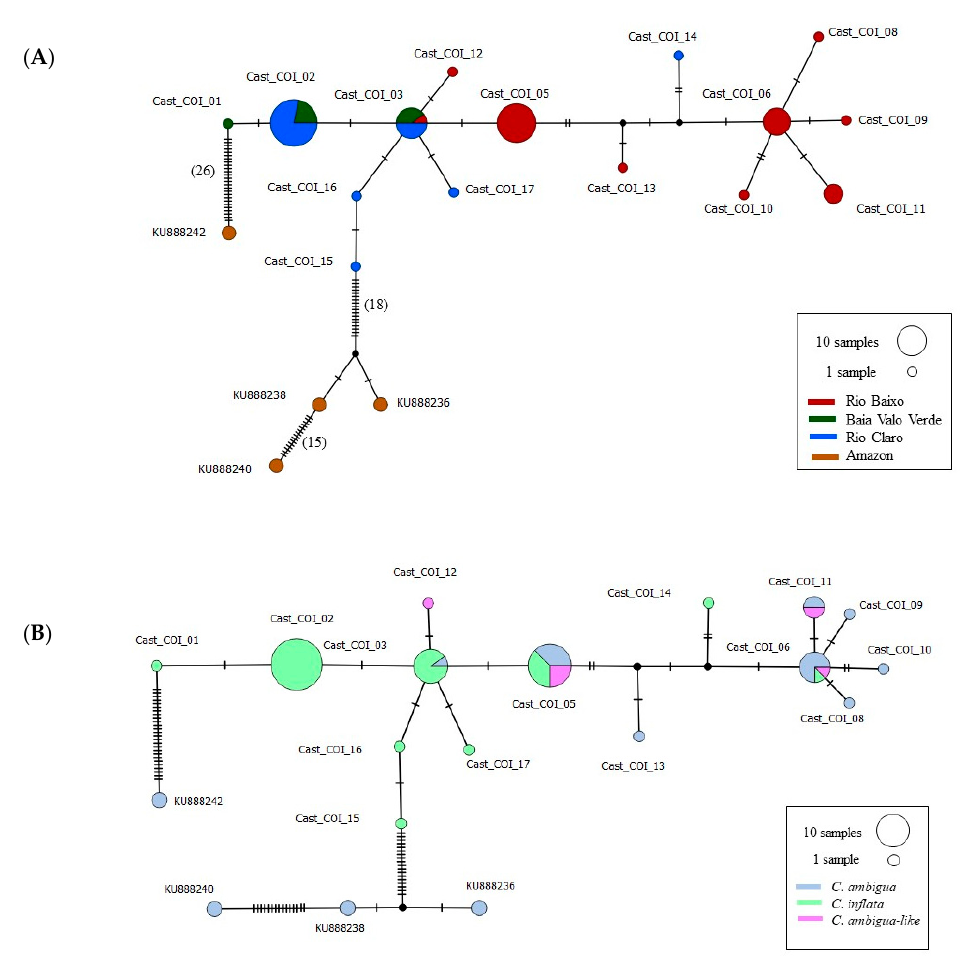
Figure 5. Haplotype networks for mitochondrial COI for C. ambigua and C. inflata across the Paraguay and Amazon River basins, considered: ( A ). on a geographic basis, and ( B ). on a taxonomic basis. The relative sizes of the circles reflect the frequencies of the respective haplotypes. Hash marks indicate the number of inferred mutations among haplotypes observed. Black dots represent inferred intermediate haplotypes that were not observed in our data set. Haplotype designations include Cast for Castalia , COI for cytochrome oxidase, and a number for each unique DNA